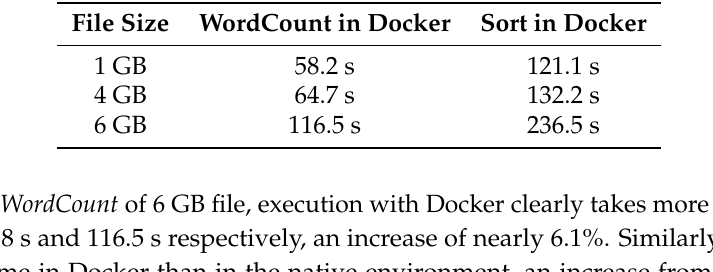
Table 2. Execution times for WordCount and Sort jobs in Virtualised